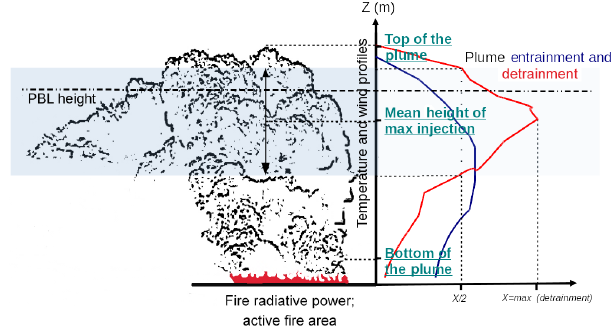
Figure 1. Schematic of an algorithm estimating plume injection height parameters. The fire input (fire radiative power and fire area) and the environmental input (temperature and wind profiles) are shown, as well as the possible output of the model: detrainment and entrainment profiles, with the derived quantities (bottom of the plume, top of the plume, mean height of maximum injection), or injection height, usually defined as the top of the